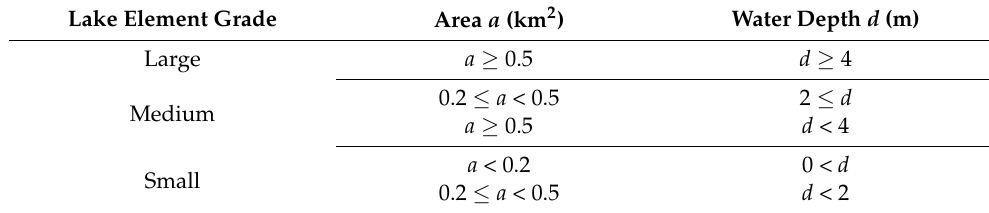
Table 8. Grading standards for the lake